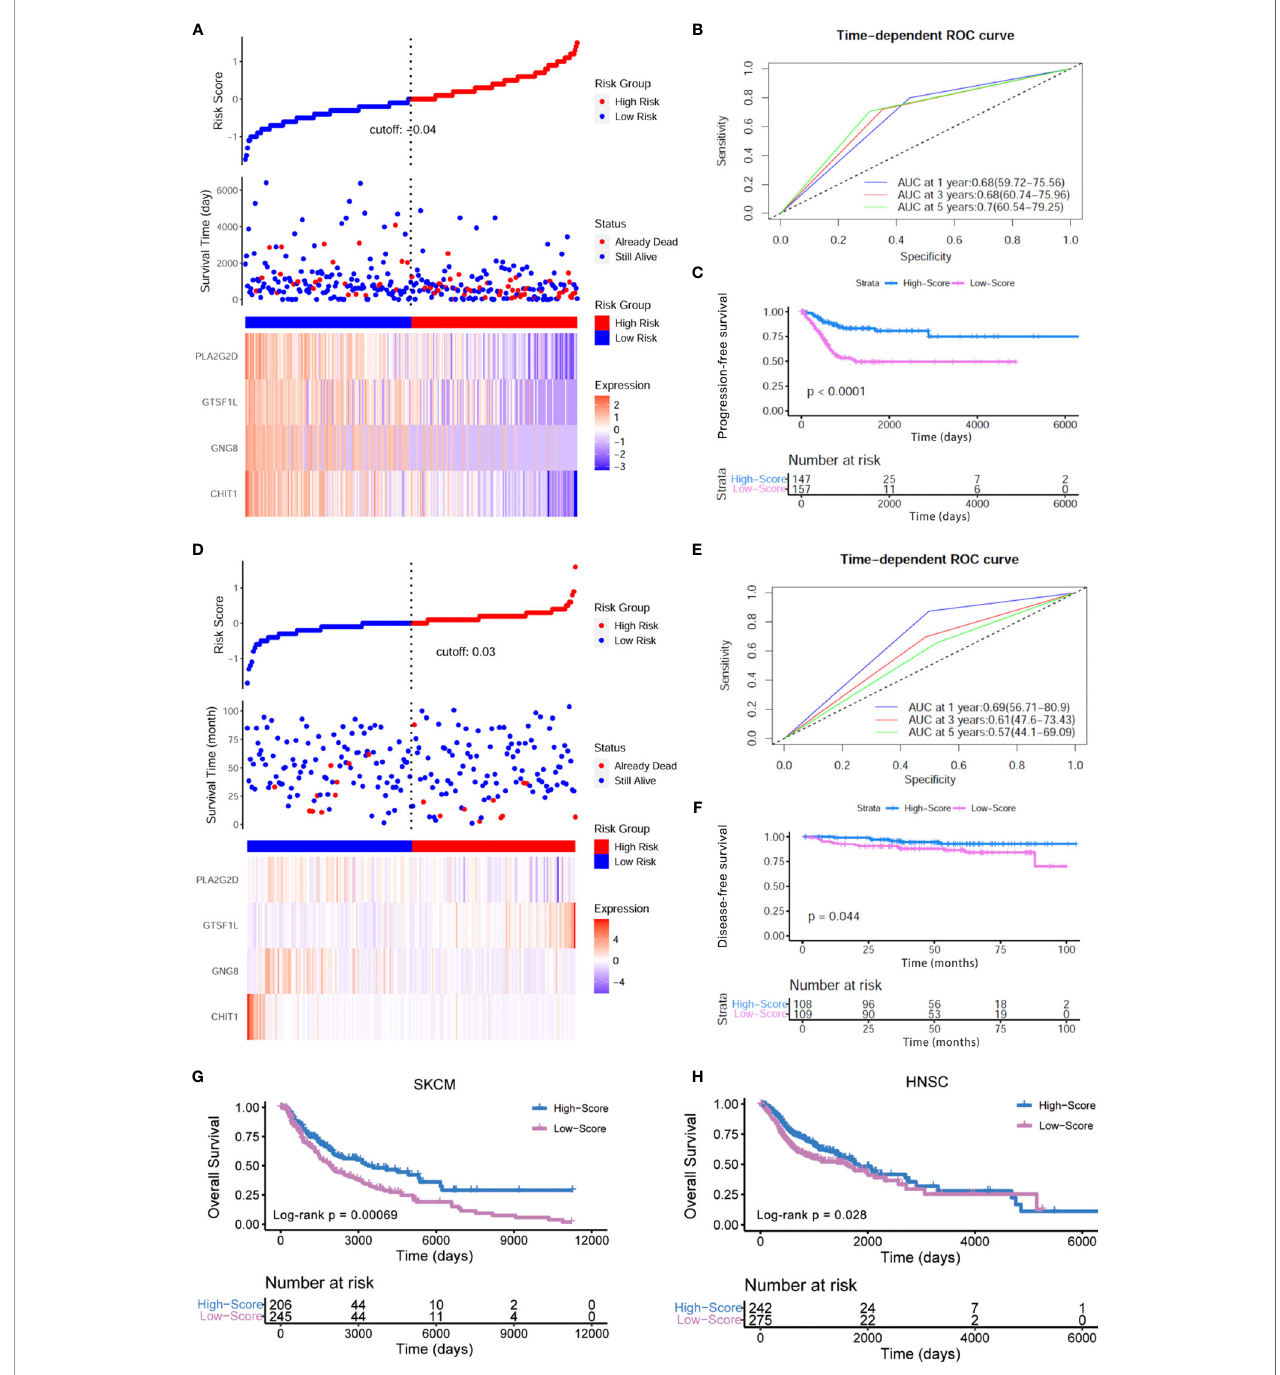
FIGURE 5 | External veri fi cation of prognostic value of this Immunoscore. (A) The risk curve and scatter plot of each sample in the TCGA-CESC cohort after realignment via ggrisk algorithm. The heatmap showed distinct expression pro fi les of four hub genes in the high- and low-risk groups. (B) The 1-, 3-, and 5-year ROC of the optimal model based on the progression-free survival of TCGA-CESC. (C) Patients in the high-score group displayed a longer progression-free survival time tested by Kaplan – Meier analysis. (D) The risk curve and scatter plot of each sample in the GSE44001 cohort (IB1 stage, n = 217) after realignment via ggrisk algorithm. The heatmap showed distinct expression pro fi les of four hub genes in the high- and low-risk groups. (E) The 1-, 3-, and 5-year ROC of the optimal model based on the disease-free survival (DFS) of GSE44001 (IB1 stage, n = 217). (F) Patients in the high-score group displayed a longer disease-free survival time tested by Kaplan – Meier analysis. (G, H) Kaplan – Meier curves for high- and low-score groups in the TCGA-SKCM (Log-rank test, p < 0.001) and TCGA-HNSC cohorts (Log-rank test, p <